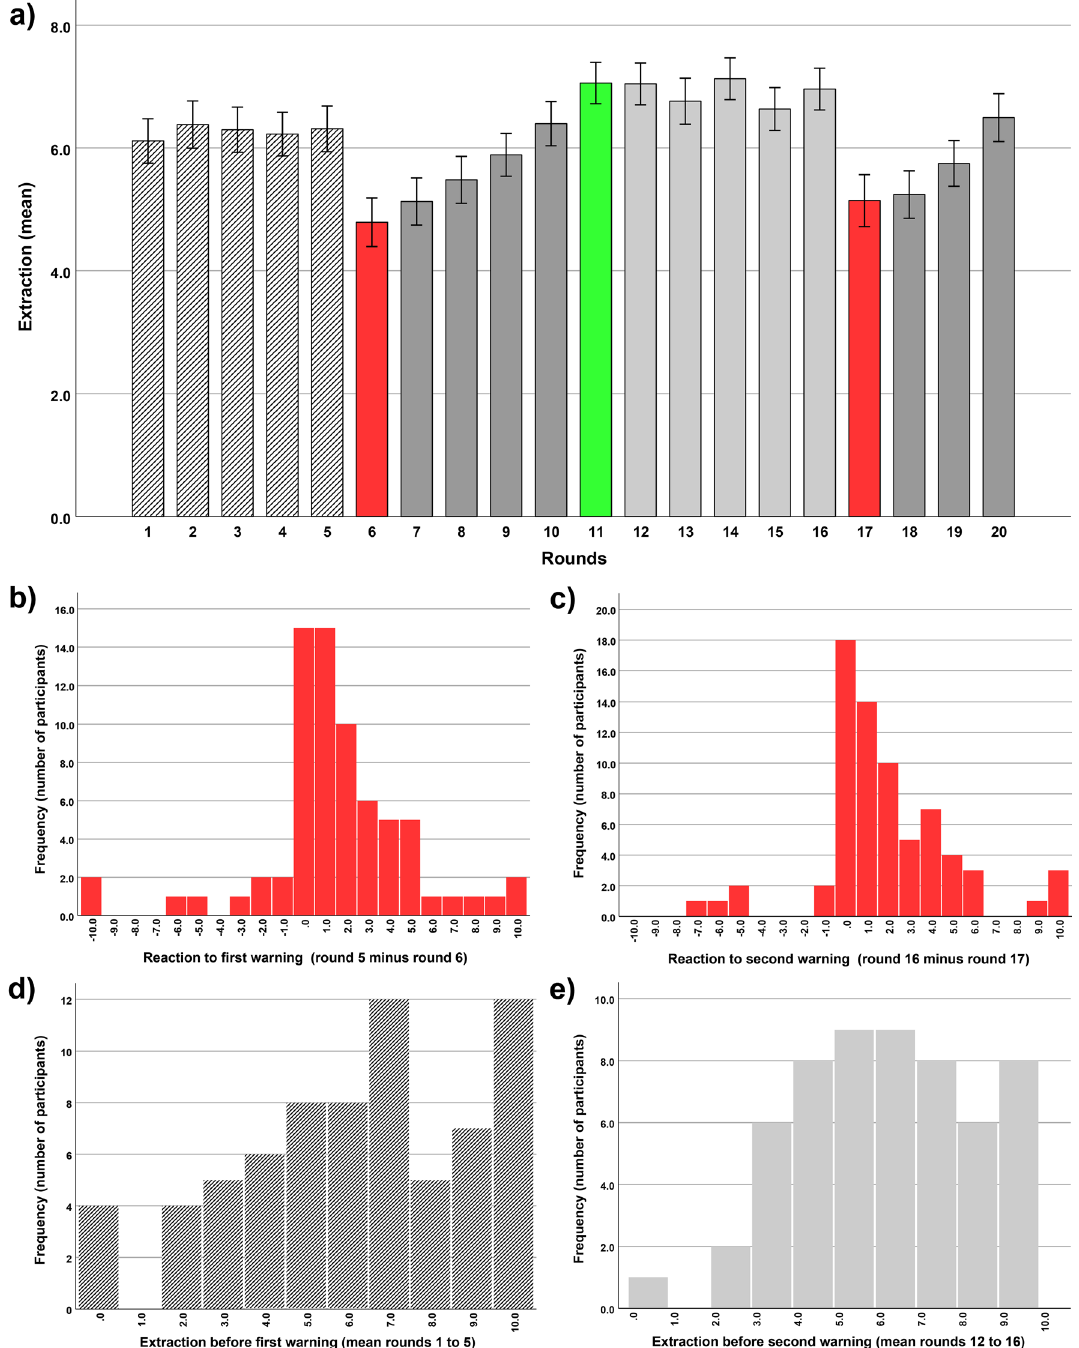
Figure 1. Average behaviour and variability in behaviour in the sequential resource dilemma. The bar graph in ( a ) illustrates the average behaviour across the 20 rounds of the sequential resource dilemma; the rounds after the first and second warning are depicted in red and the round after the indication that the situation is easing is depicted in green. Bar graphs in ( b – e ) depict histograms, demonstrating considerable variability in the first ( b ) and second ( c ) warning reaction and in the five rounds (mean) before the first ( d ) and second ( e ) warning. Note that warning reactions are calculated as differences between rounds immediately before the warnings and immediately after the warnings (round 5 minus round 6/round 16 minus round 17). Error bars depict standard errors of the